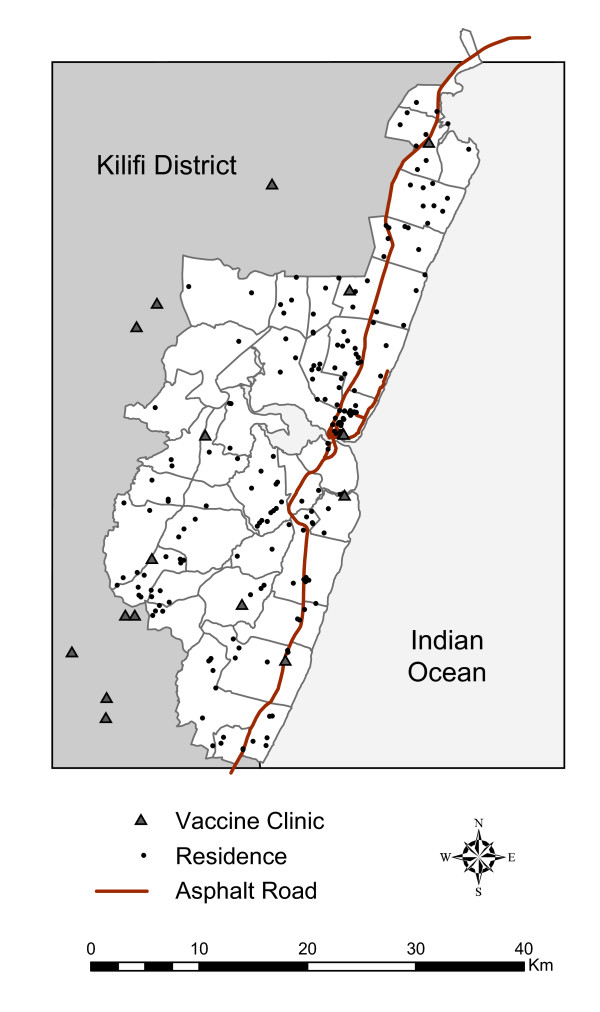
Map of the sub-locations of the Kilifi DSS showing vaccine clinic locations and 204 children's residences in the simple random sample survey